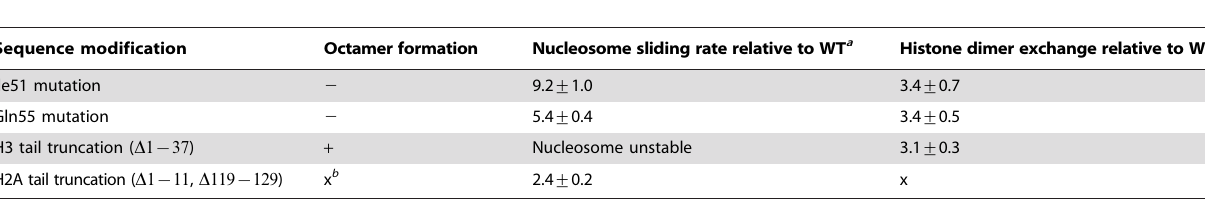
Table 1. Experimental results on the effect of alanine mutagenesis and tail-truncation on nucleosome dynamics.